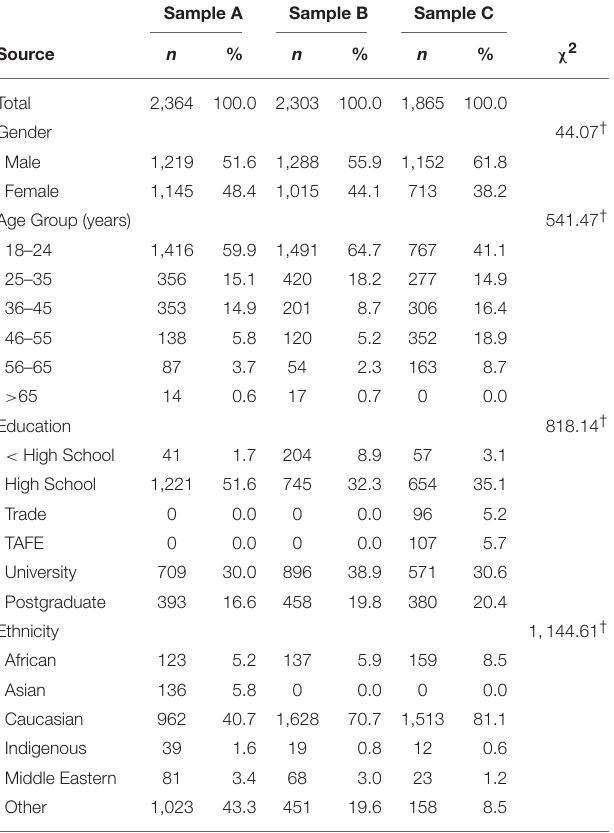
TABLE 1 | Sociodemographic characteristics of participants. Sample A Sample B Sample